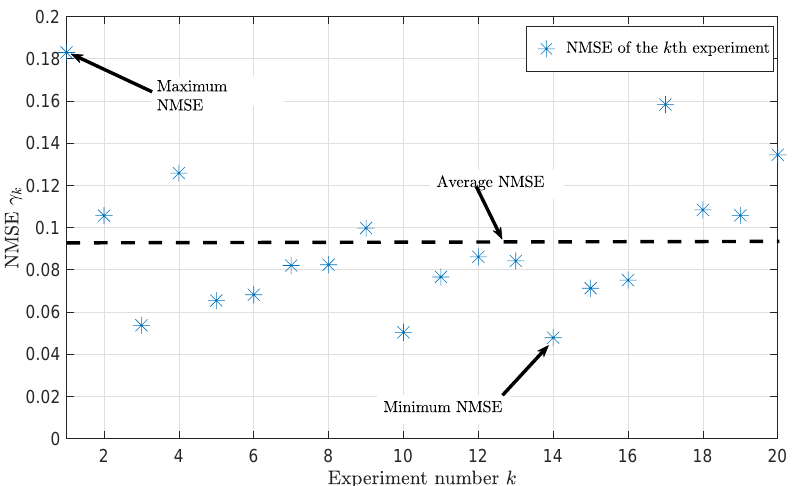
( 1 ) ( t ) of the channel k ( 1 ) ( t ) for k = 1, 2, . . . , K k